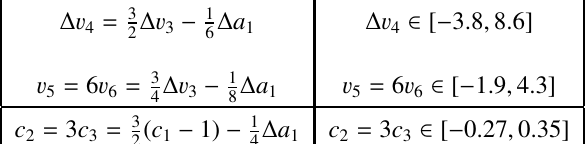
Table 3. First two rows: correlations among the coe ffi cients Δ v 3 : = v 3 − 1, Δ v 4 : = v 4 − 1 / 4, v 5 and v 6 of the HEFT Higgs potential expansion in Eq. (9) that need to hold, at O (1 / Λ 2 ), if SMEFT is a valid description of the electroweak sector. The third row includes the leading correlations for the Yukawa G ( h ) function of Eq. (11), constraining c symmetric point h ∗ ). We make use of current 95% confidence interval for the top Yukawa coupling